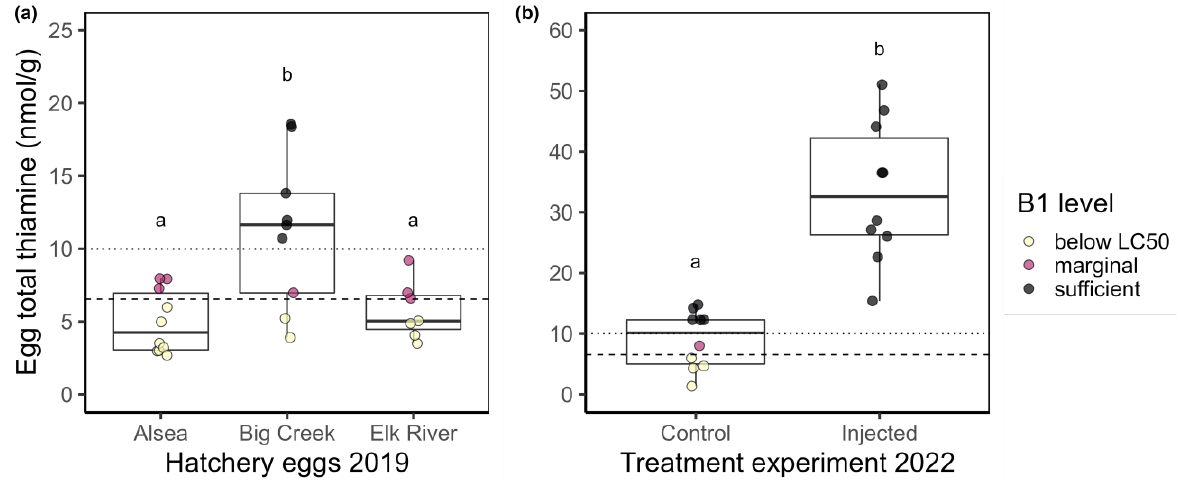
Figure 1. Boxplots (25%, 50%, and 75% quantiles comprise the box) with overlaid raw data points of steelhead egg total thiamine measurements from ( a ) three coastal Oregon hatcheries in 2019, and ( b ) control and injected female eggs from 2022. Egg concentrations are colored based on thiamine concentration thresholds. Yellow points are below LC50 for steelhead of 6.54 nmol/g (dashed line [37]), red points lie between LC50 and the value considered sufficient (10 nmol/g, dotted line [38]), and black points represent egg thiamine concentrations that are likely sufficient for early growth and development as determined from individual-based models for recruitment to lake trout populations [38]. Different letters (a or b) indicate post hoc permutation tests suggest group differences at p < 0.05. Note the y-axes have different scales.